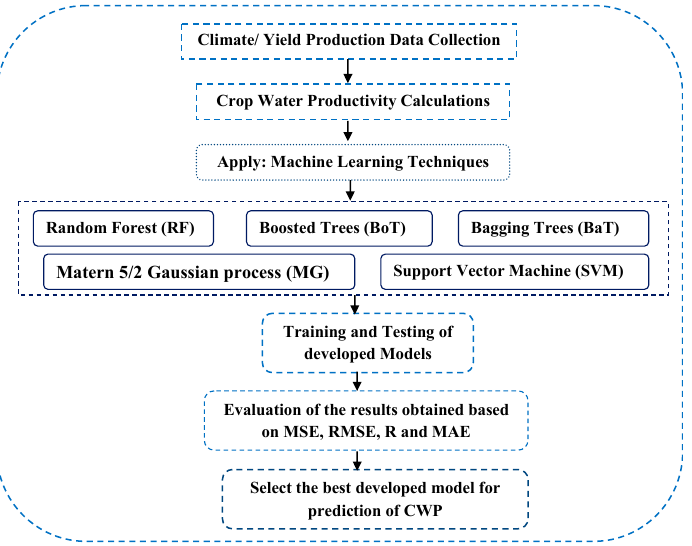
Figure 1. Flowchart of the adopted methodology in the study area.